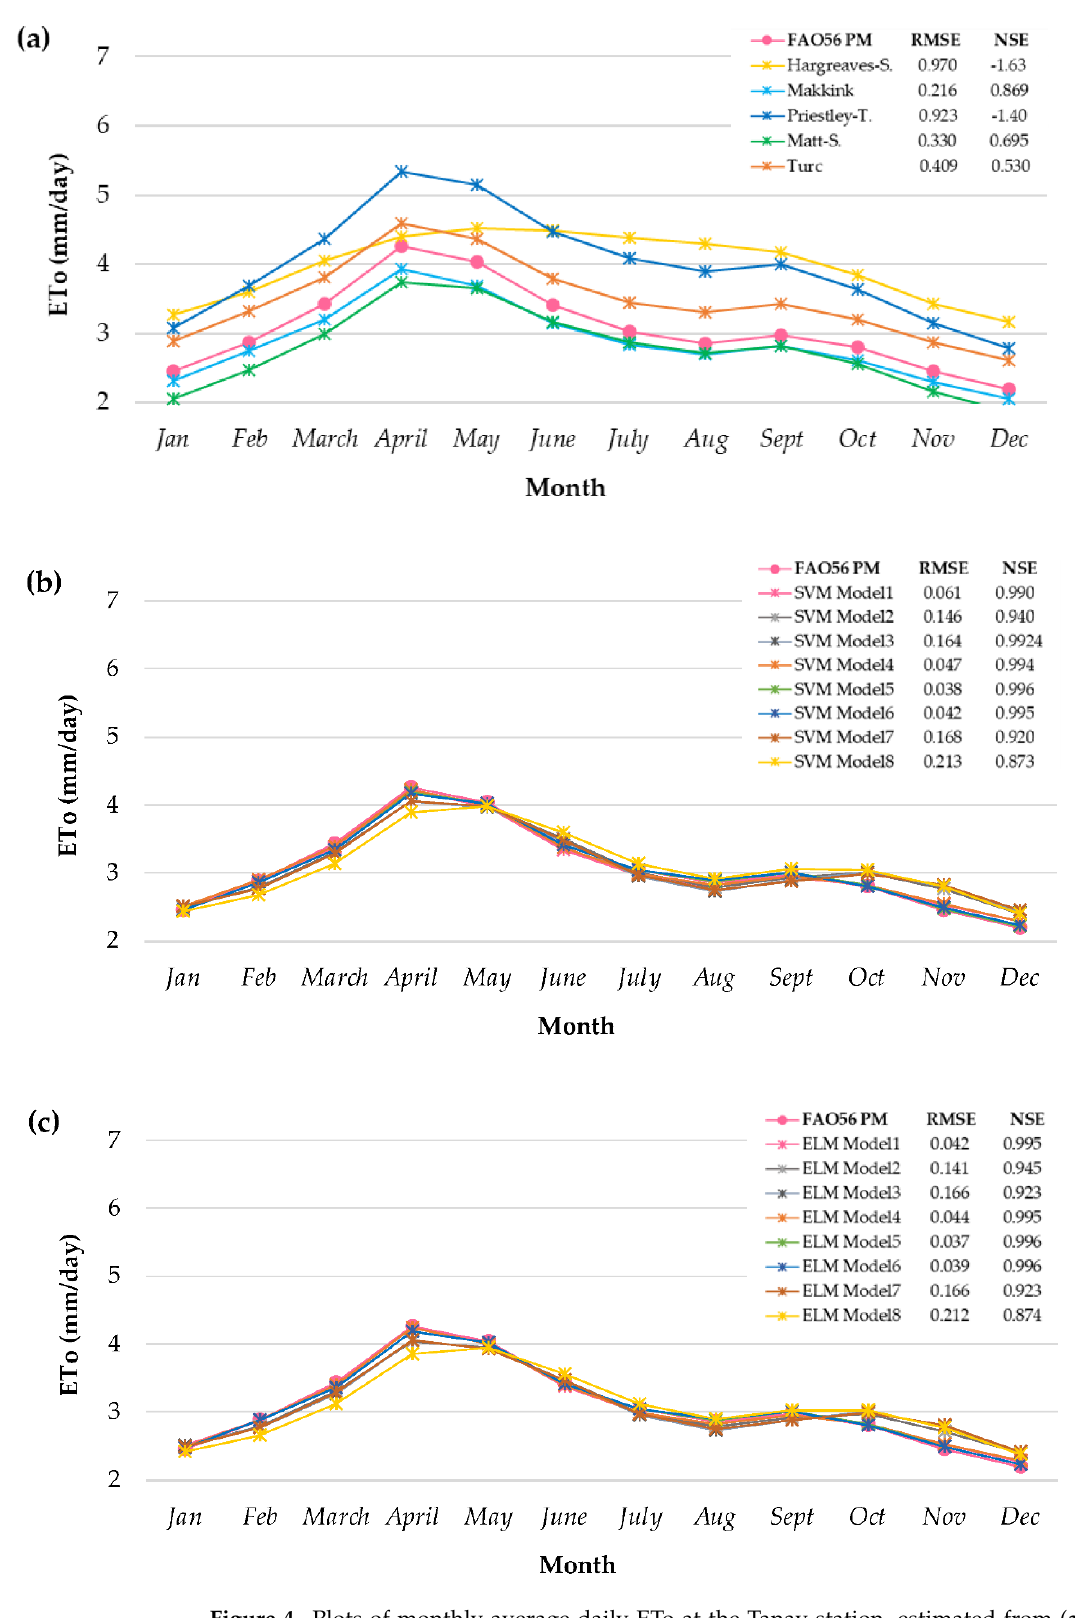
Figure 3. Plots of monthly average daily ETo at the UPLB station estimated from ( a ) empirical equa- tions, and calibrated machine learning models of ( b ) Support Vector Machine and ( c ) Extreme Learning Machine.